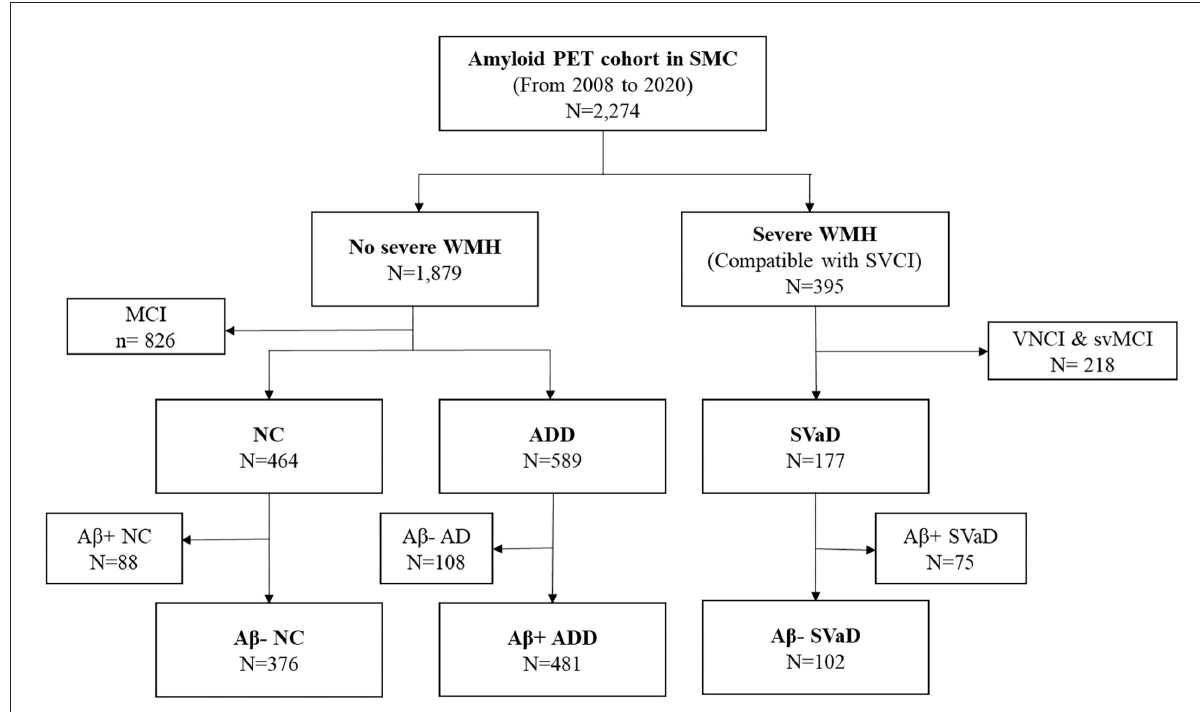
FIGURE1 Flowchart for subjects selection. PET, positron emission tomography; SMC, Samsung medical center; WMH, white matter hyperintensities; MCI, mild cognitive impairment; VNCI, vascular no cognitive impairment; svMCI, subcortical vascular MCI; NC, normal cognition; ADD, Alzheimer’s disease dementia; SVaD, subcortical vascular